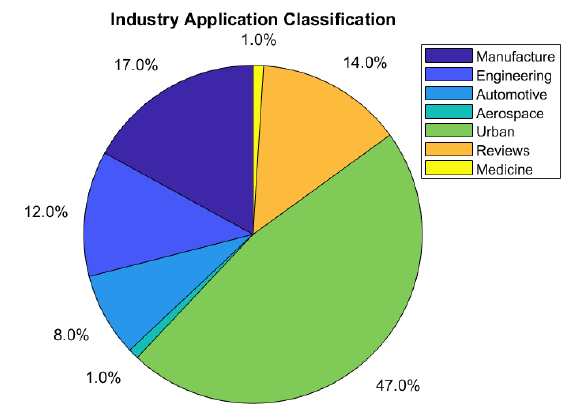
Figure 2. Publication classification by the application